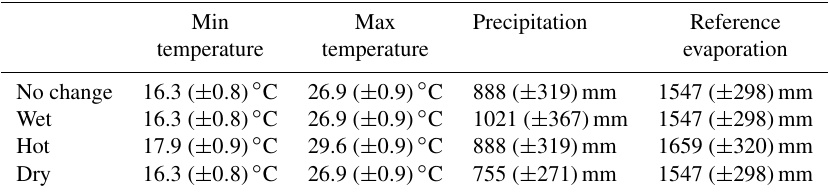
Table 1. Average (daily temperature, annual precipitation) weather conditions (1980–2010) in